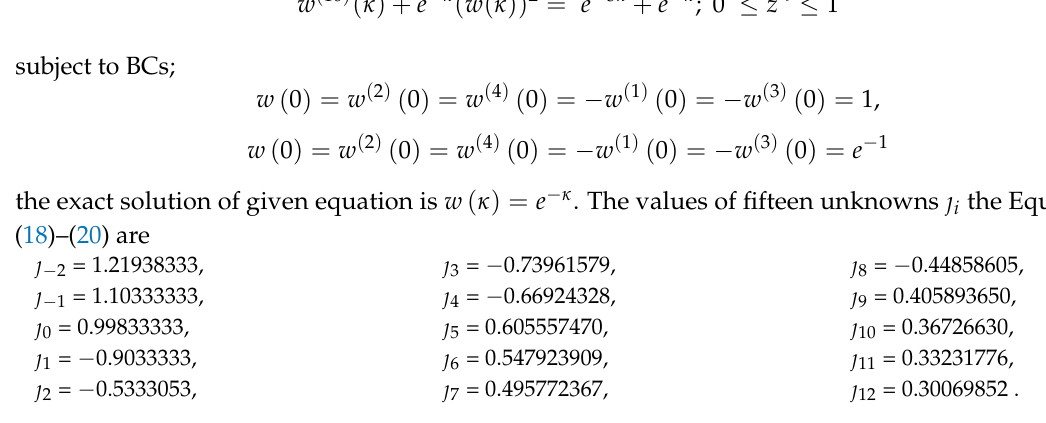
Table 8. Analyzing exact solution and CBS solution of problem 3 at h = 1